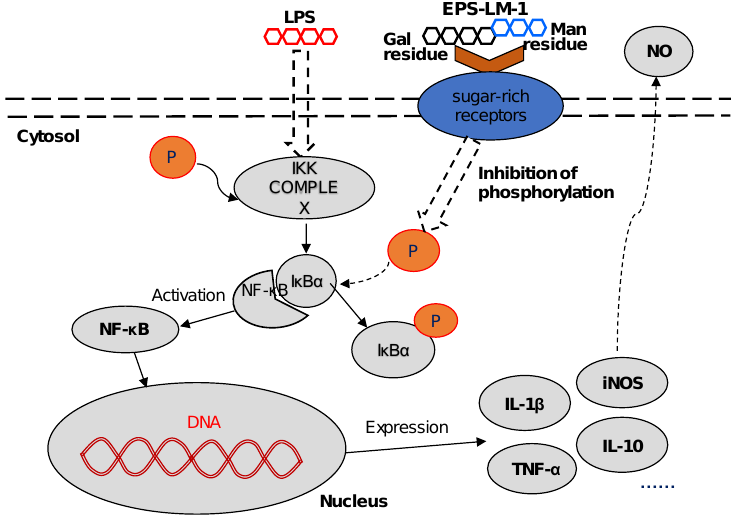
Figure 5. Proposed signaling pathway for the inhibition of LPS-induced inflammatory responses by EPS-LM-1 in THP-1 cells.